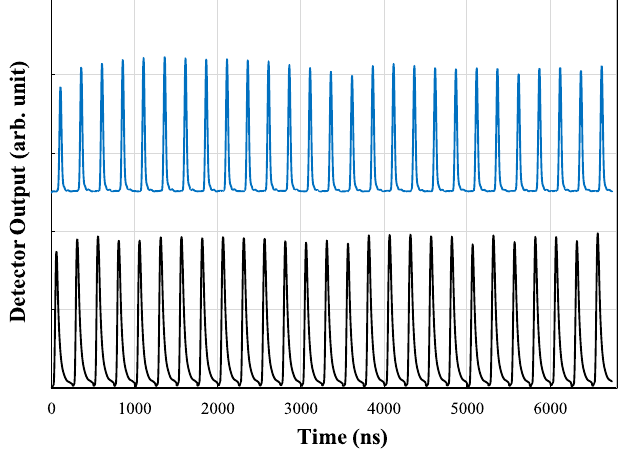
FIG. 8. Output waveforms of the Faraday cup (top) and PMT (bottom) from a laser comb consisting of 27 comb teeth. For each laser comb tooth, only 250 ns is displayed.